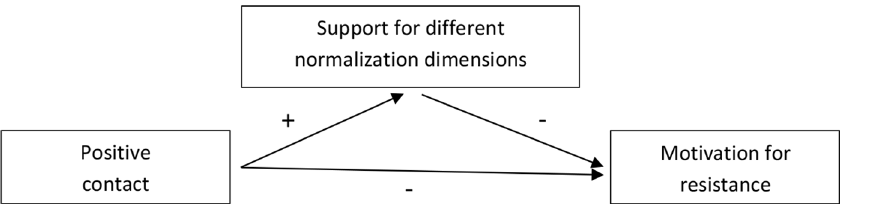
Figure 1. The hypothesized relationships between positive contact, support for different dimensions of normalization and motivation for